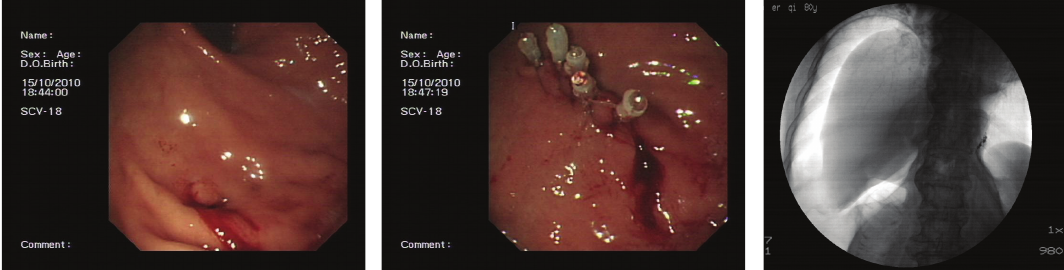
Figure 3: The fundus perforation was sutured by clips. The gas in peritoneal cavity was shown by X-ray.